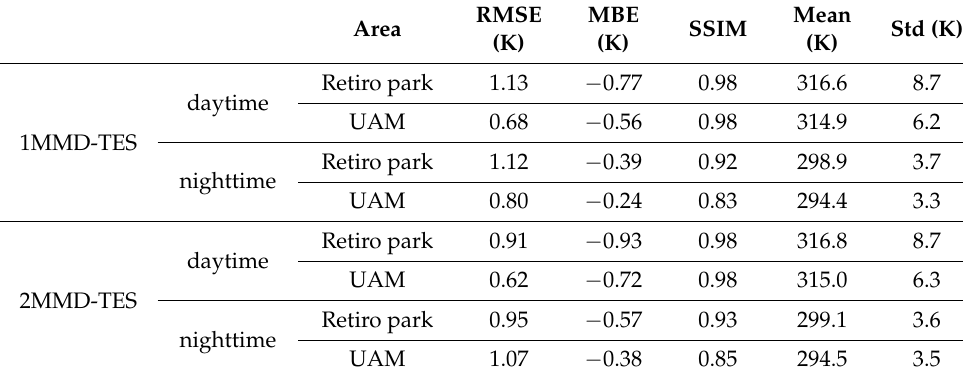
Table 5. RMSE, MBE and SSIM between 7-band TES from [59] and 1MMD-TES and 2MMD-TES, respectively. First-order statistics of the 1MMD-TES and 2MMD-TES over the Retiro park and the UAM areas are also shown. Date: 4 of July